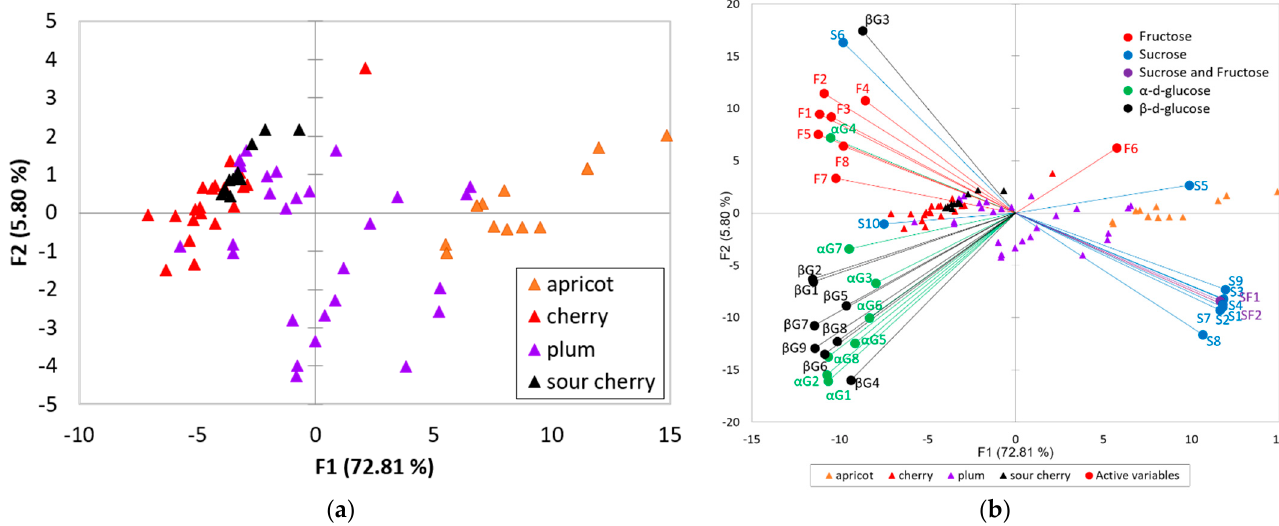
Figure 3. ( a ) PCA score plot of four fruit samples’ variety derived from conventional 1 H-NMR spec- tra; ( b ) correlation between the signals and factors responsible for fruits’ variety